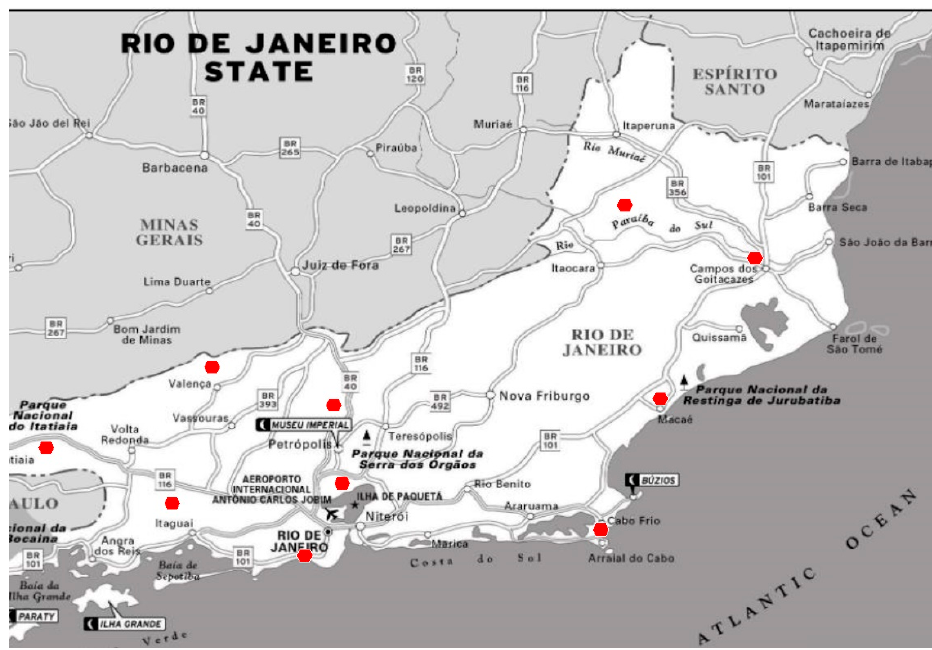
Figure 1. Representative meteorological stations across the State of Rio de Janeiro, Brazil.